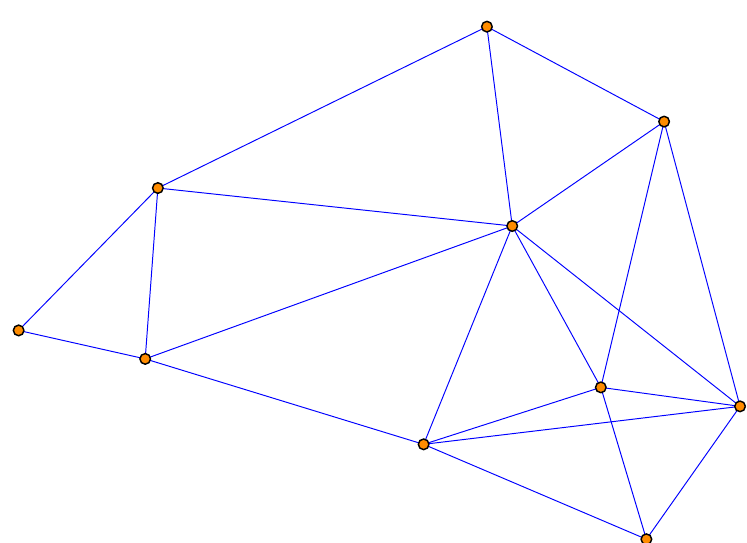
Figure 2. The topology of the sensor network used in the